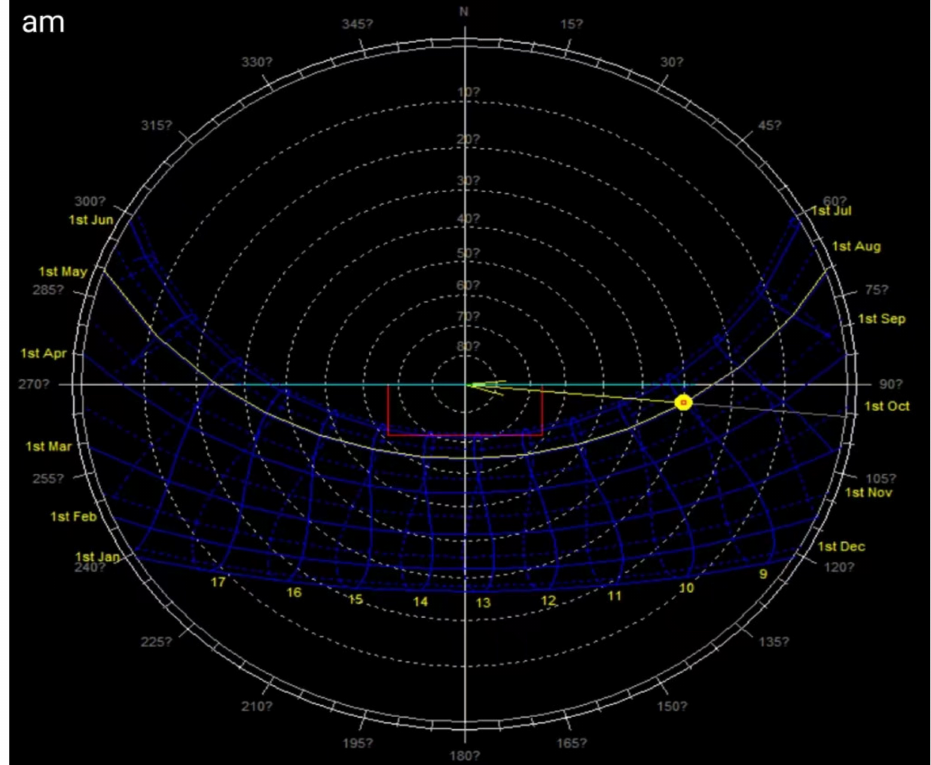
Figure 12. Sphere shadow diagram of the planned